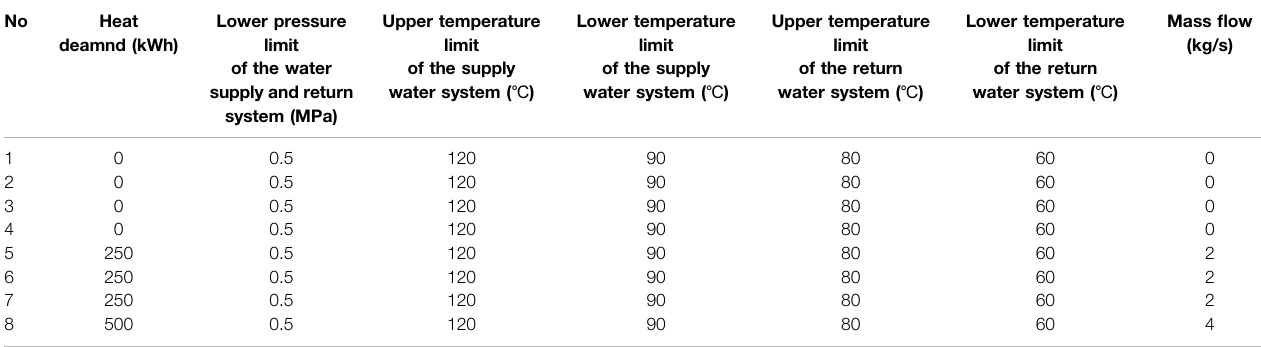
Table A1 | The relevant parameters of